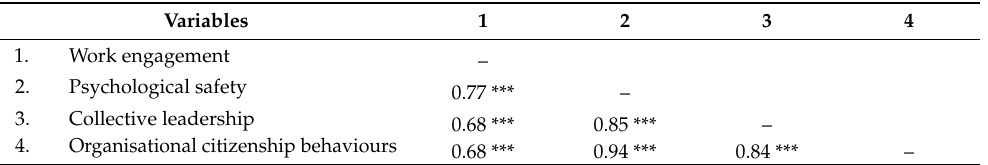
Table A3. Inter-factor correlations of all latent